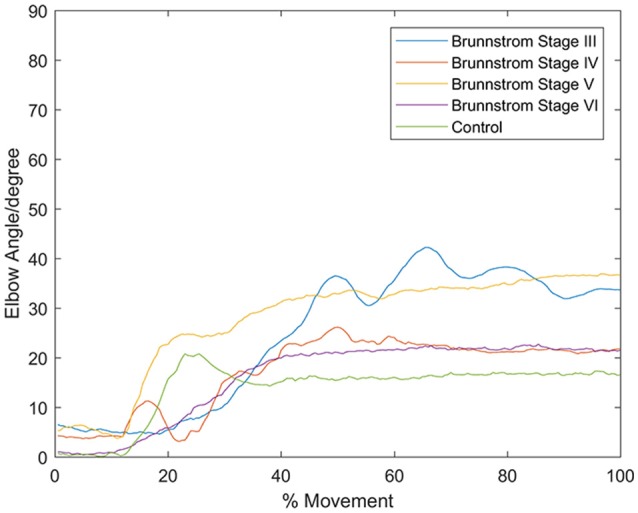
Elbow angle of individual subject from each Brunnstrom Stage and the control group. Stroke patient in Brunnstrom Stage III had the largest elbow joint angle, and had obvious perturbations in the holding phase. The angles in Stage IV to VI were relatively small and smooth compared to Stage III. In control group, there's a peak in the joint angle, which means the subjects bent their elbow and then extended when performed voluntary reaching task.